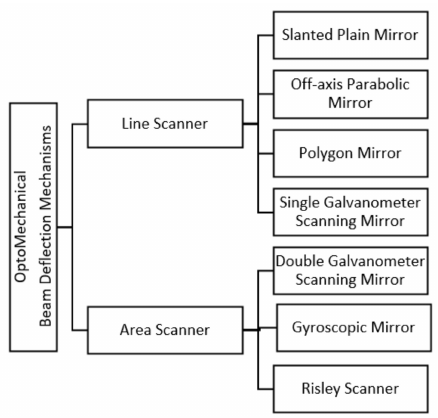
Figure 5. Classifications of optomechanical scanning mechanism for 2D and 3D LiDAR